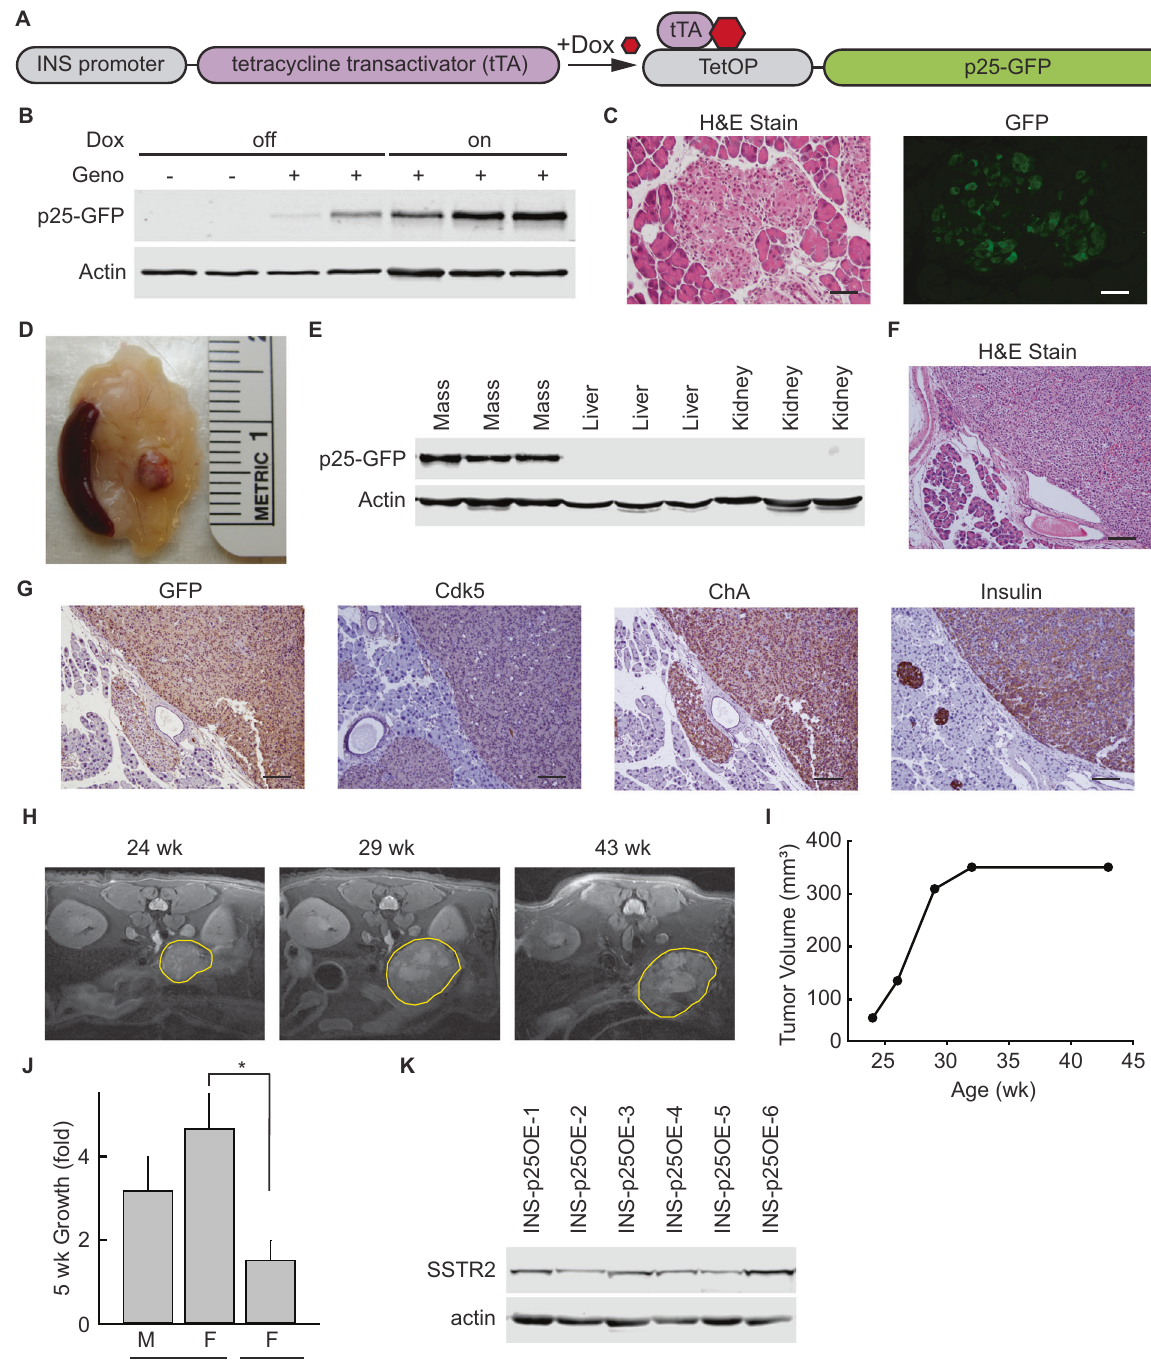
Fig. 2 Aberrant activation of Cdk5 generates PanNETs in an inducible bi-transgenic mouse model. A Schematic of genetic system for regulated tissue-speci fi c expression of p25-GFP. B Immunoblot for expression of p25GFP in islets isolated from transgene negative ( − ) and INS-p25OE ( + ) mice with (on) or without (off) administration of 1 g/L Dox for 4 – 5 weeks. C H&E stain and immuno fl uorescence of sections of pancreas from INS-p25OE mice at 4 weeks post-p25-GFP induction. D Representative gross image of a pancreatic mass from INS-p25OE mice. E Immunoblot for expression of p25-GFP in pancreatic mass, liver, and kidney at 12 months induction. H&E stain ( F ), and immunostains ( G ) of primary PanNET from an INS-25OE animal. Scale bars = 100 μ m. H Axial MRI sections from a representative INS-p25OE mouse. PanNET circumscribed in yellow. I Quantitation of tumor volume over time from a representative INS-p25OE mouse. J Tumor growth, normalized to initial volume, during the linear growth phase; males (M; n = 4) and females (F; n = 3 for each group) administered dox since weaning (on) or dox since weaning followed by discontinuation for 5 weeks after initial tumor detection (off). On and off dox only compared within female groups. K Immunoblot for expression of SSTR2 and actin in INS-p25OE